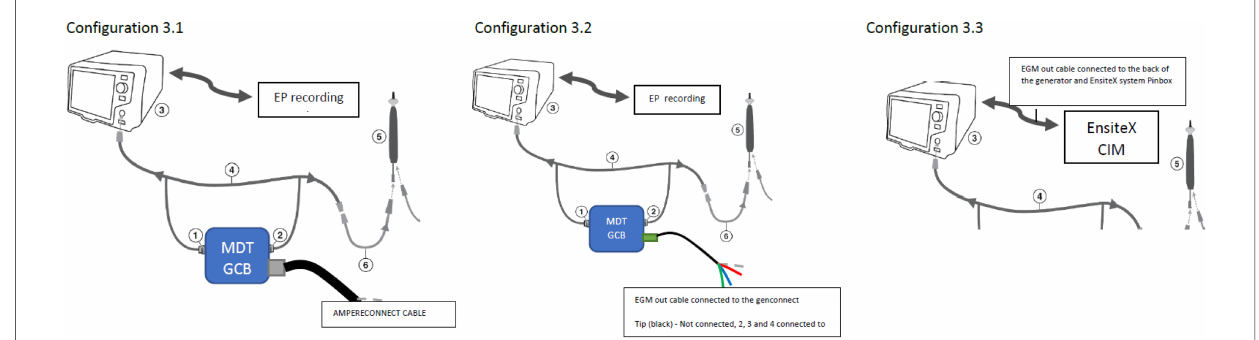
FIGURE 3 Test con fi gurations (setups). Con fi guration 3.1 — DTA connected to the EnsiteX via AmpereConnect cable connected to the MDT Genconnect. Con fi guration 3.2 — DTA connected via EGM out cable from the genconnect to the Ensite CIM (without distal as it is not wired). Con fi guration 3.3 EGM cable from RFG back to CIM and not from